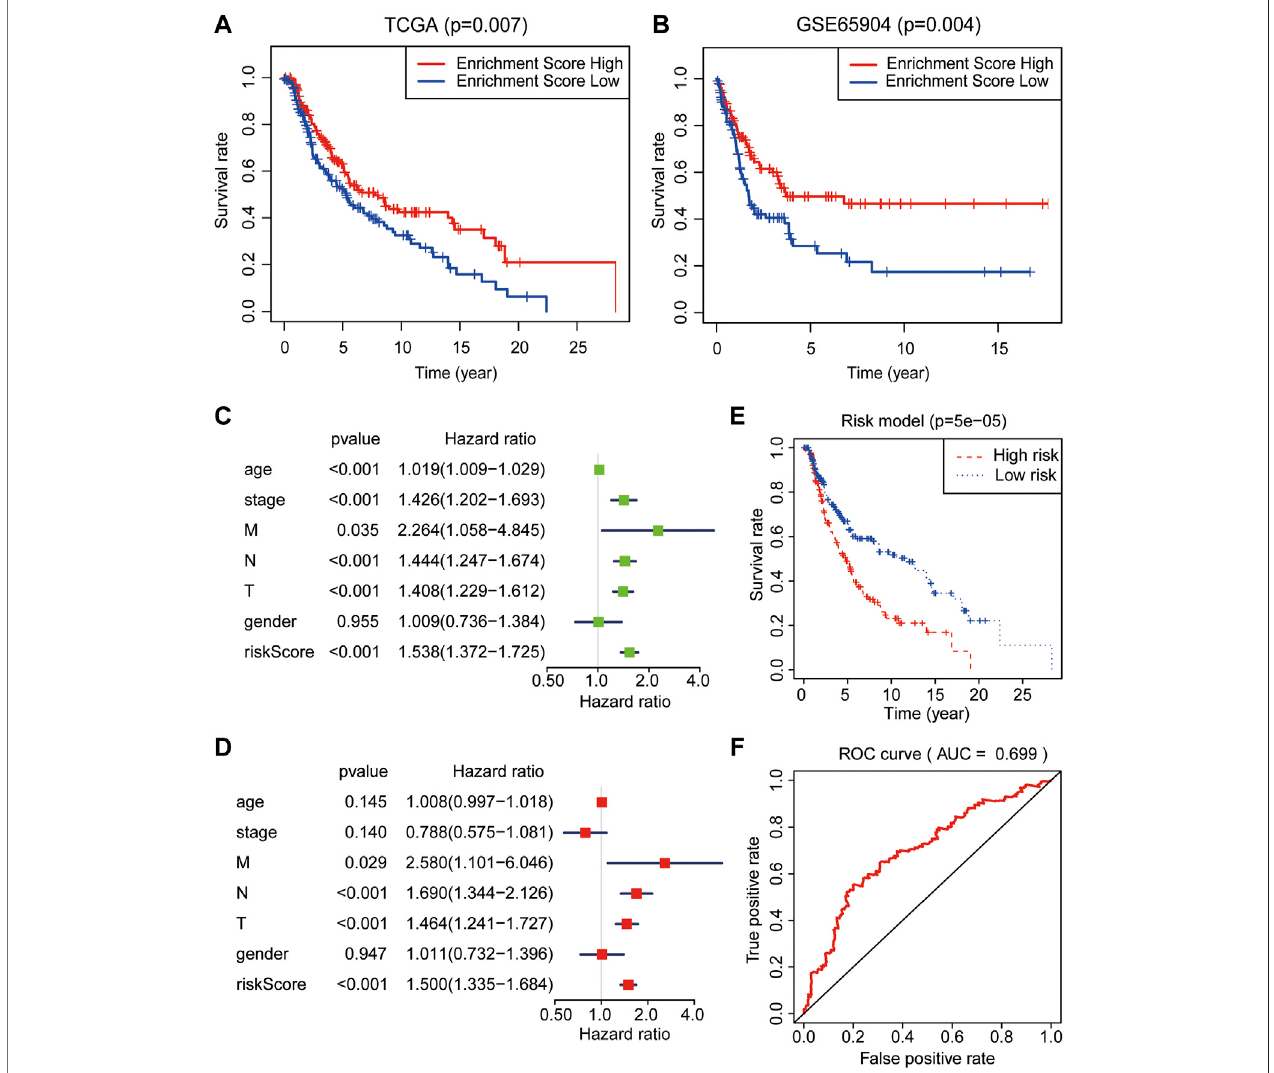
FIGURE3| Prognosticanalysisofthemodule – geneofferroptosisinSKCM.TheKaplan – MeiersurvivalcurvesintheTCGA (A) andGSE65904databases (B) .The enrichment score act as a protect factor in both the training cohort and validation cohorts. Univariate (C) and multivariate (D) Cox regression analyses of the risk model obtained from the LASSO-logistic regression analysis in the TCGA database. p values were calculated using Fisher ’ s exact test. (E) The Kaplan – Meier survival curve showed the survival bene fi ts in the low-risk group. (F) The receiver operating characteristic curve (ROC) curves for the prediction of 5-year survival rates using the risk model in